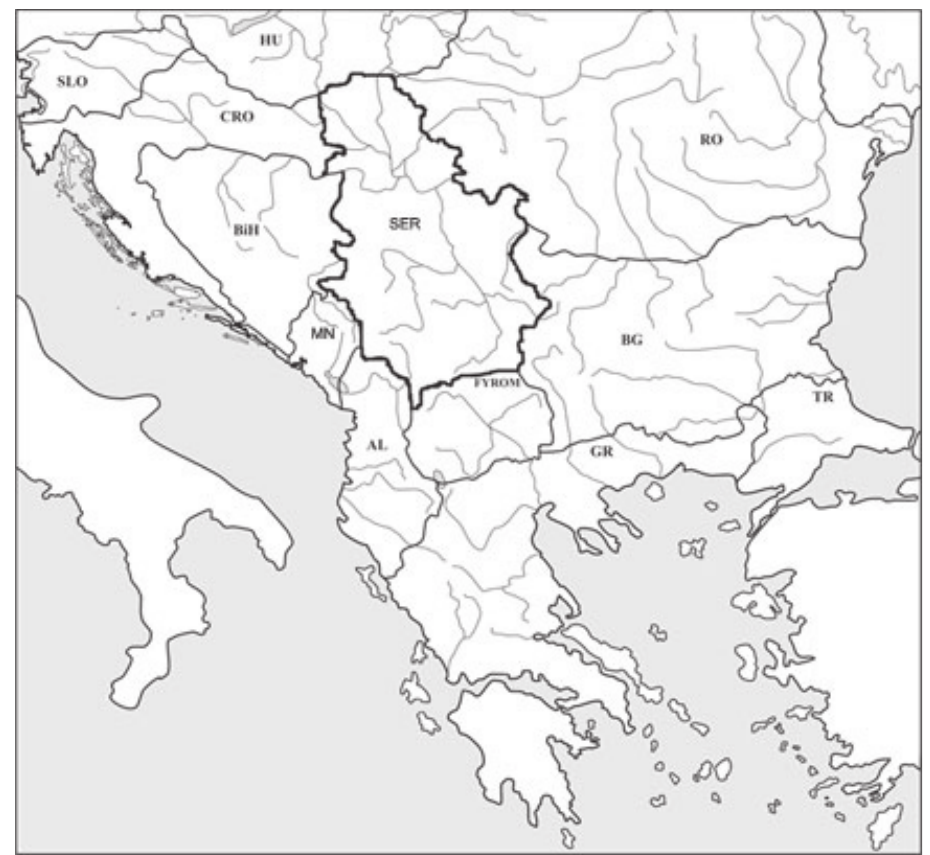
Figure 1. Geographical position of Serbia in the Balkan